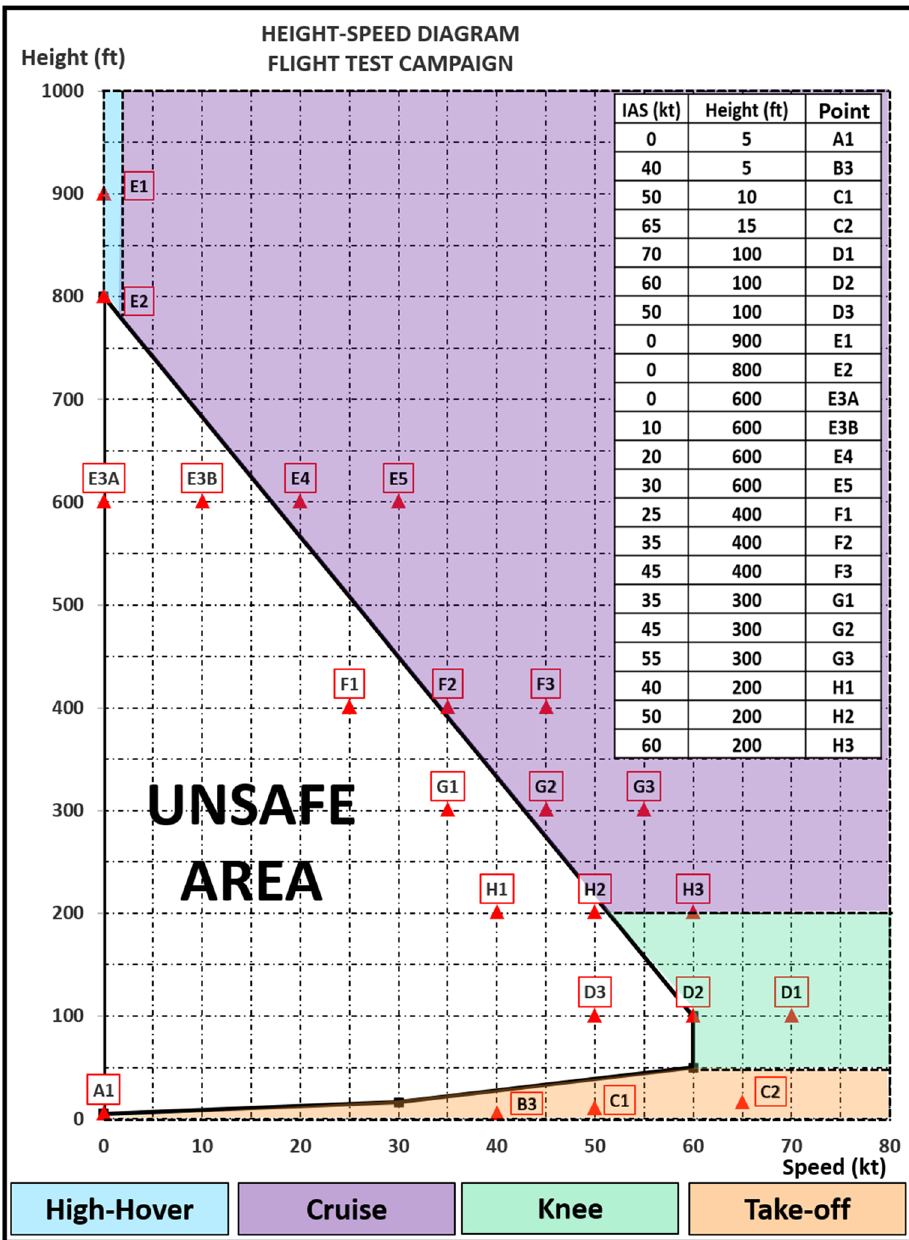
Figure 2. Height-Speed Diagram and the four partitions proposed, i.e., High-hover, Cruise, Knee, and Take-off. The table in the upper right corner shows the height and speed combinations tested during the test campaign as well as their different encodings (Letter-Number).